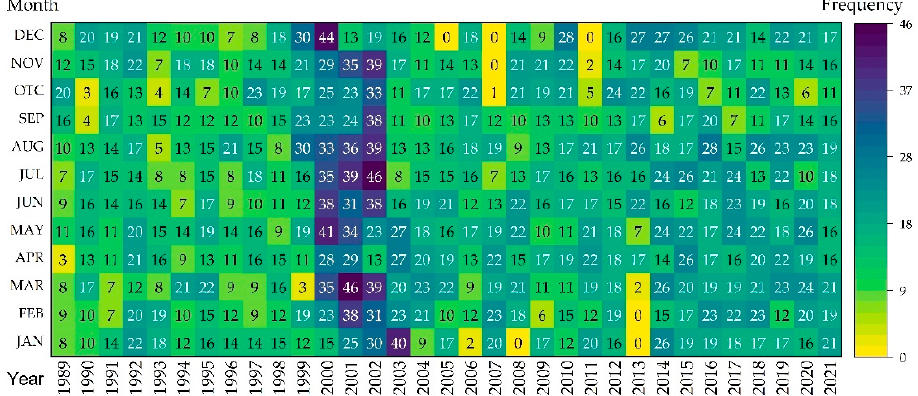
Figure 2. Monthly frequency charts of Landsat5, Landsat7 and Landsat8 were observed in GEE.